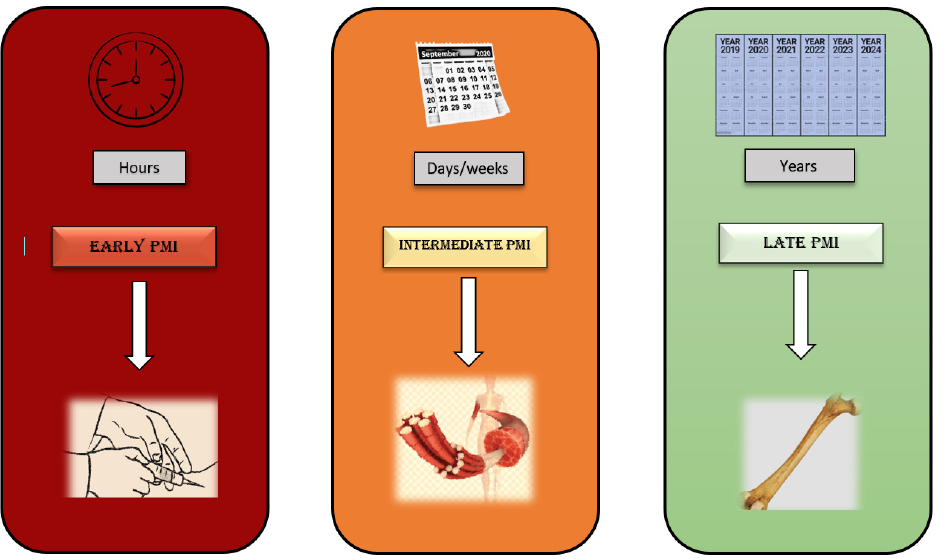
Figure 6. Operating protocol proposed in early PMI (analysis of biological fluids), intermediate PMI (muscle analysis) and late PMI (bone analysis).